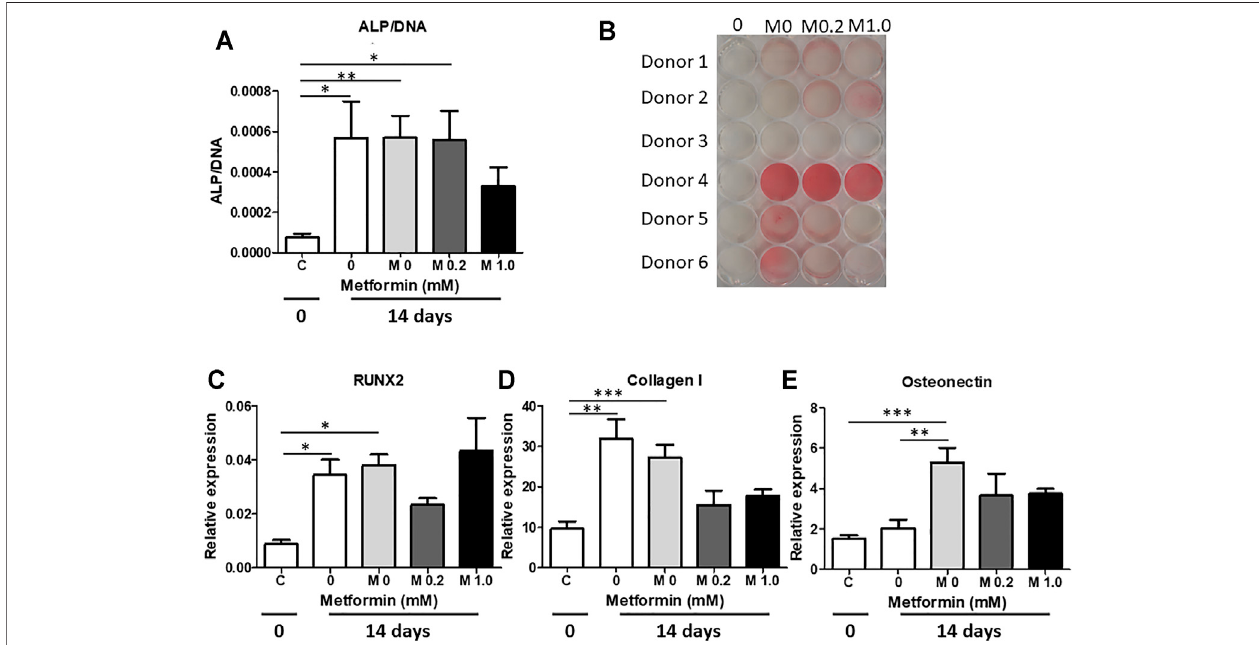
FIGURE 2 | Metformin does not increase mineralization by periodontal ligament fi broblast cultures. Metformin was used in two concentrations (0.2 and 1.0 mM) in mineralization assays. (A) Alkaline phosphatase enzyme activity per cell at 0 (C) and 14 days (0 – normal medium without metformin; M0, M0.2 and M1.0 0, 0.2 and 1.0 mM Metformin in Mineralization medium). (B) Alizarin red staining at 21 days, (C – E) : genes expression of RUNX2 (C) , Collagen I (D) and Osteocalcin (E) at 0 days (C) and at 14days(0 – normalmediumwithoutMetformin;M0,M0.2andM1.00,0.2and1.0 mMMetformininMineralizationmedium).*: p < 0.05;**: p < 0.01;***: p < 0.001.Alldata are from n (cid:2) 6